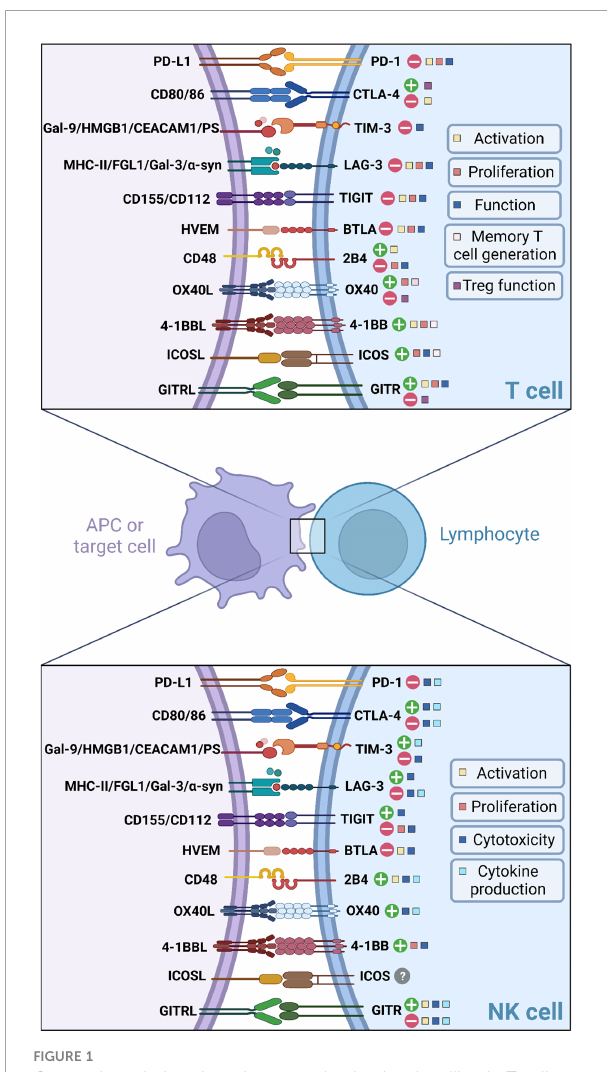
FIGURE 1 Current knowledge about immune checkpoint signalling in T cells and NK